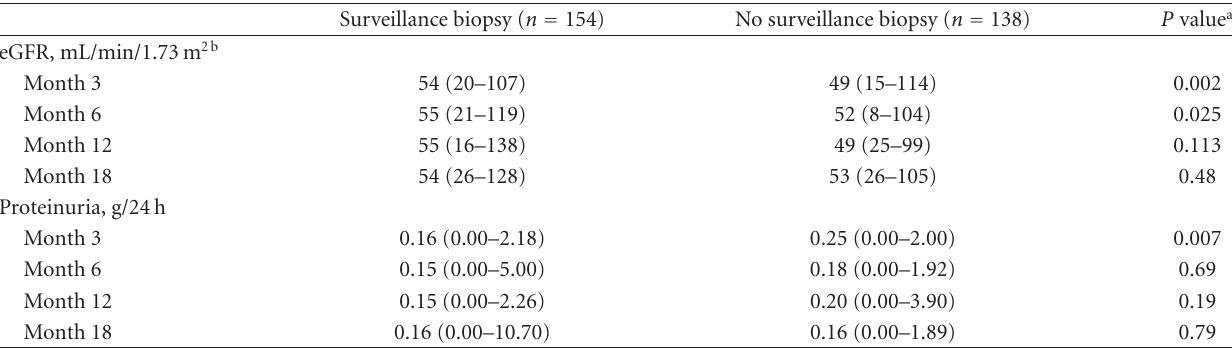
Table 3: Renal function according to time posttransplant.